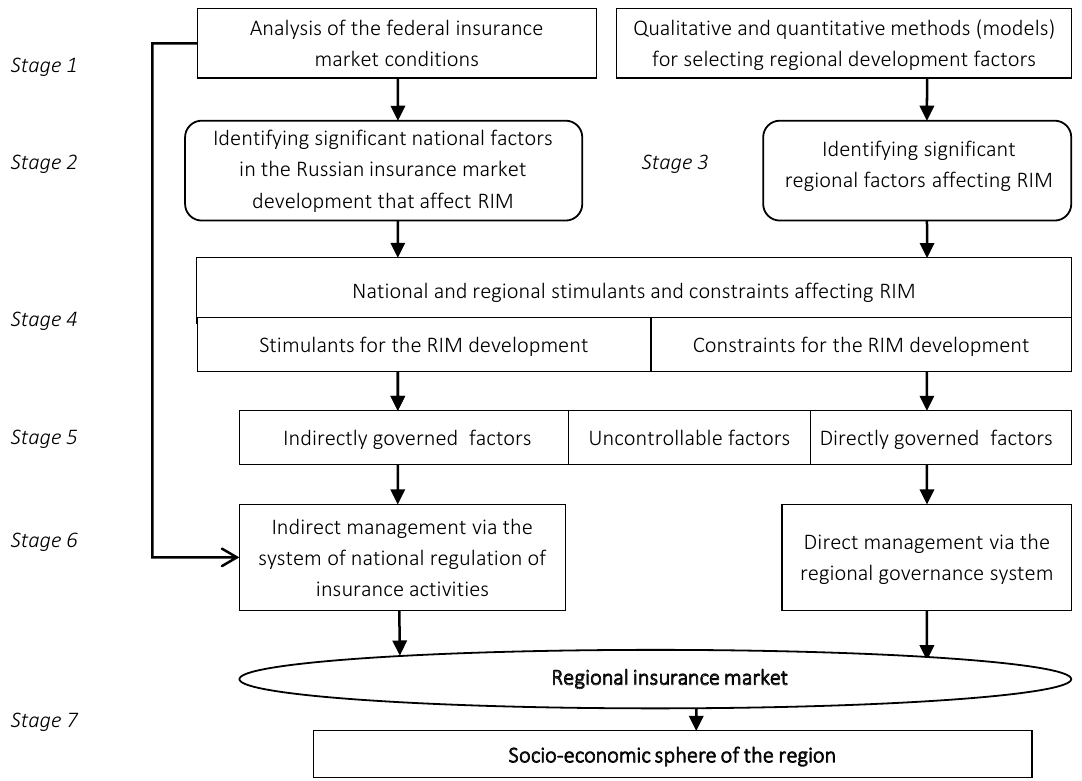
Figure 3. Scheme of the influence of national and regional stimulants and constraints on the development of RIM and the